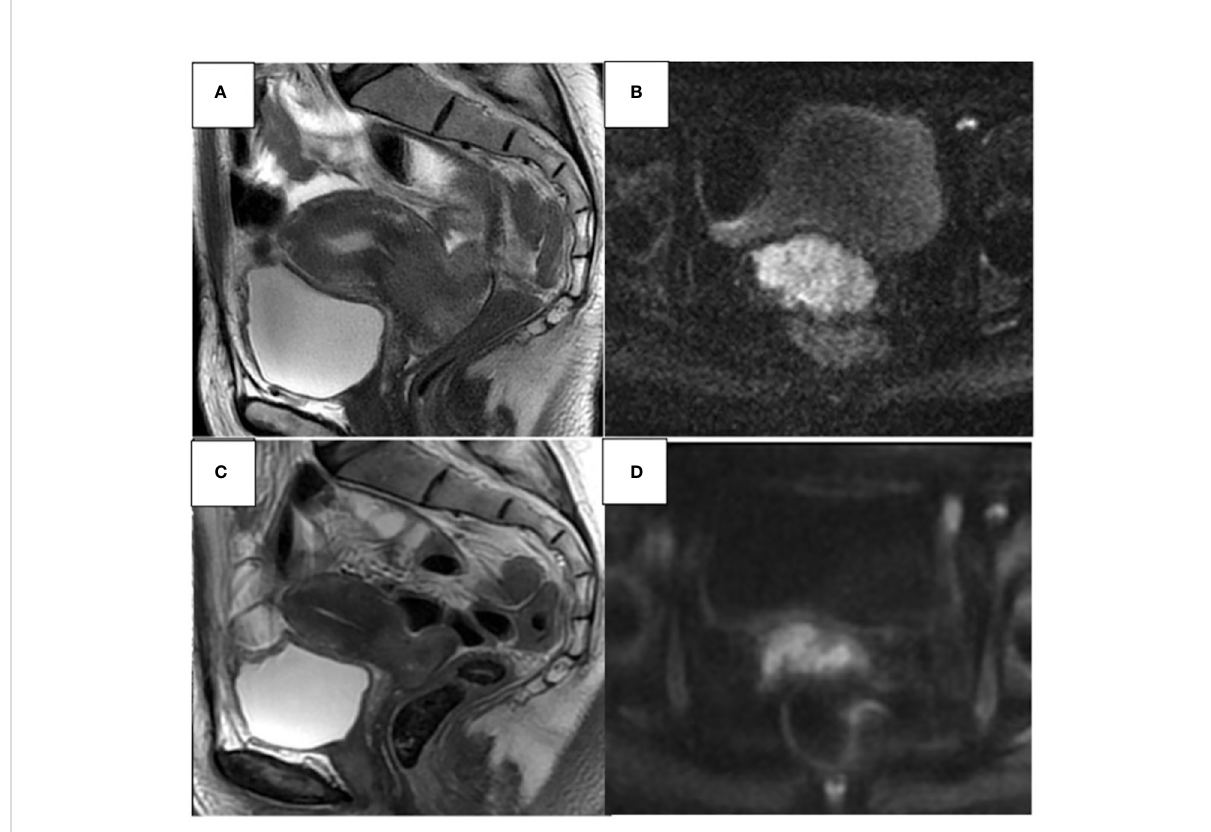
FIGURE 2 48- year-old woman. Sagittal T2W and axial DWI MR images show an invasive CC extending from the uterine isthmus to the external uterine ori fi ce, laterally in fi ltrating both vaginal fornices, and extending beyond the stromal ring with extensive in fi ltration of the parameters. (A, B) . Partial response (C, D) approximately 30% reduction of cervical heteroplastic